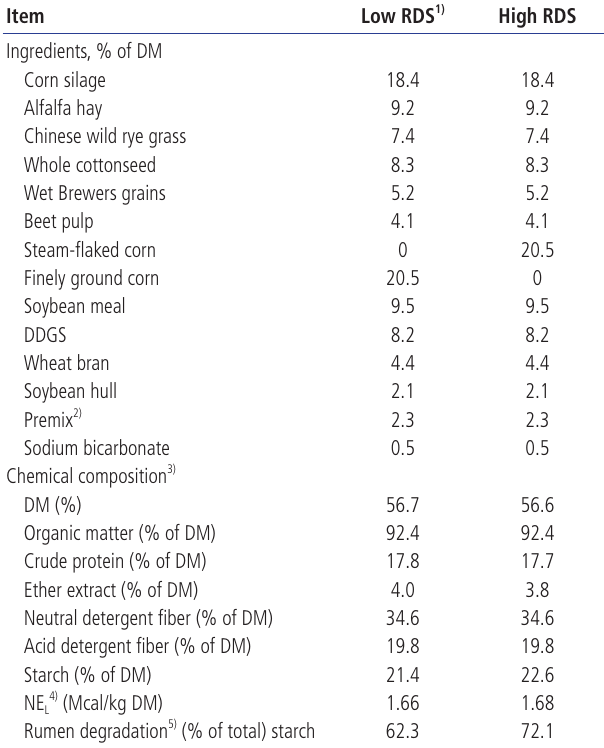
Table 1. Ingredients and calculated chemical compositions of experimental total mixed ration